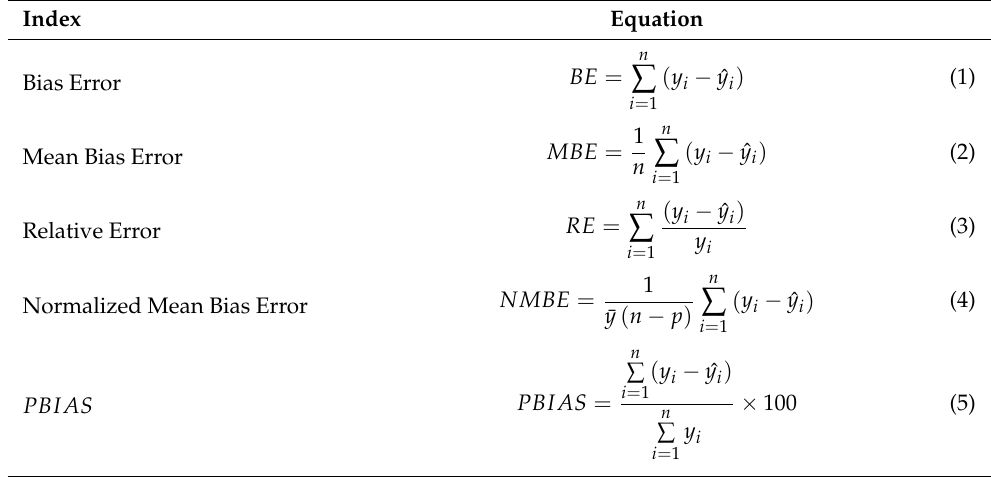
Table 1. Bias error measures.